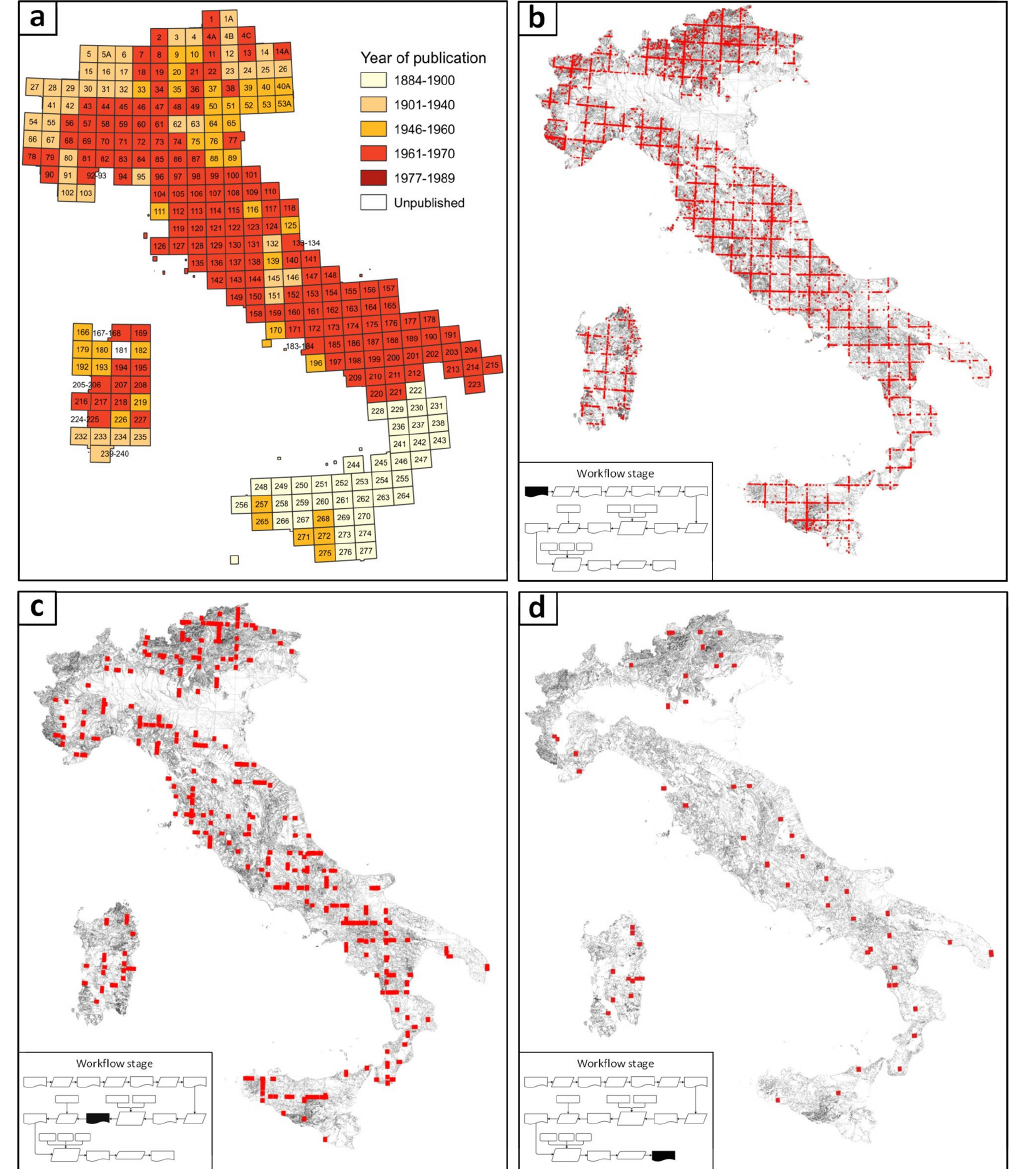
Figure 4. (a) The 277 sheets of the geological map of Italy at the 1 : 100000 scale classified according to the years of publication, as visualized in Console et al. (2017), Fig. 3. (b) The 12711 NS–EW-oriented segments (red lines) with different lithotypes in the two sides and sinuosity equal to 1. (c) The 405 red lines longer than 1000m left after semi-automatic classification. The 294266 unclassified vector polygons of the source dataset are shown as background in panels (b) and (c) . (d) The 58 red lines longer than 1000m left after the expert analysis of the semi-automatic output. The 100705 unclassified vector polygons derived from the dissolve GIS operation performed after the classification phase are shown as background. Insets in panels (a) , (b) , and (c) indicate the classification stage to which each map refers, according to the scheme in Fig.